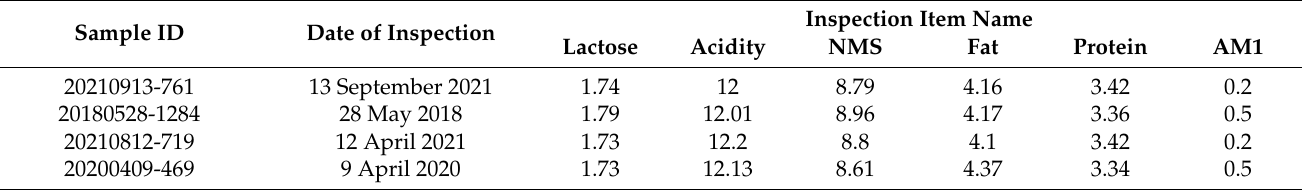
Table 2. Part raw data of food inspection between 2013 and 2021. Chinese standard GB 25190-2010 (National Standard for Food Safety Sterilized